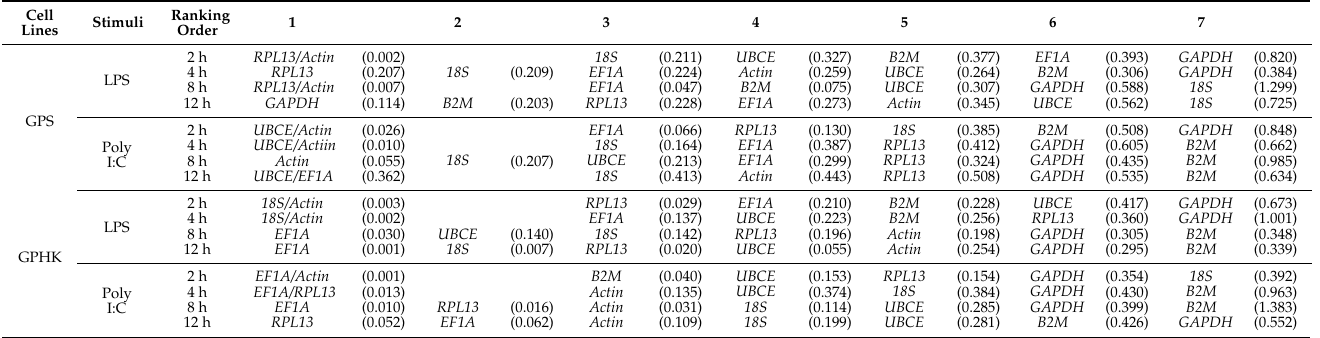
Figure 4. Optimum pairs of housekeeping gene candidates necessitated for normalization in GPS cells under stimulation with LPS for 2 ( A ), 4 ( B ), 8 ( C ) and 12 h ( D ) according to geNorm analysis. The optimal number of the reference gene depends on V n/n+1 value via geNorm analysis. Moreover, the value is popularly less than 0.15. Table 7. The expression stability of housekeeping gene candidates in GPS and GPHK cells under stimulation with LPS or Poly I:C for 2, 4, 8 and 12 h, as assessed by NormFinder.